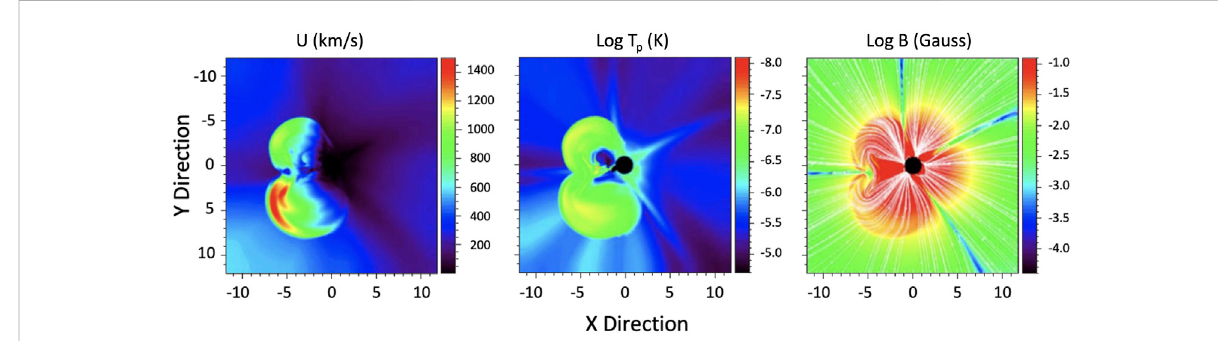
FIGURE 2 Z = 0 slices in the Carrington coordinates of the AWSoM MHD solution showing the radial velocity (left panel) , proton temperature (middle panel) , and magnetic fi eld strength (right panel) with projected fi eld lines overlaid att = 30 min after the CME initiation(adapted from Li et al.,